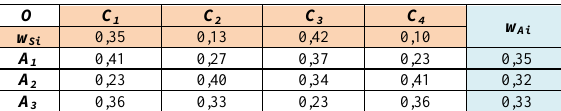
Table 6. Matrix of pairwise comparisons of the alternatives in relation to the sub-criterion S 1